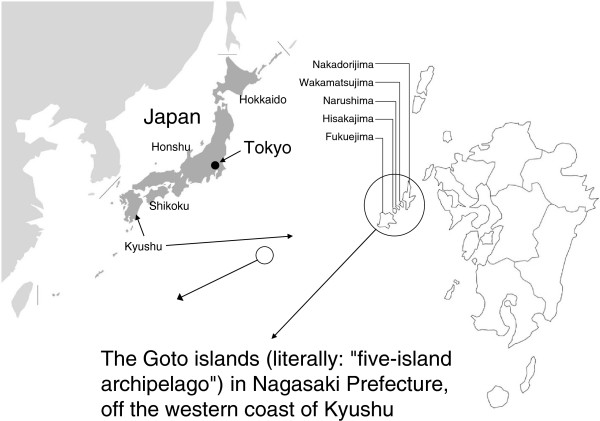
Research area. The subjects resided in a district located in the northern region of the Goto islands in Nagasaki prefecture in western Japan.